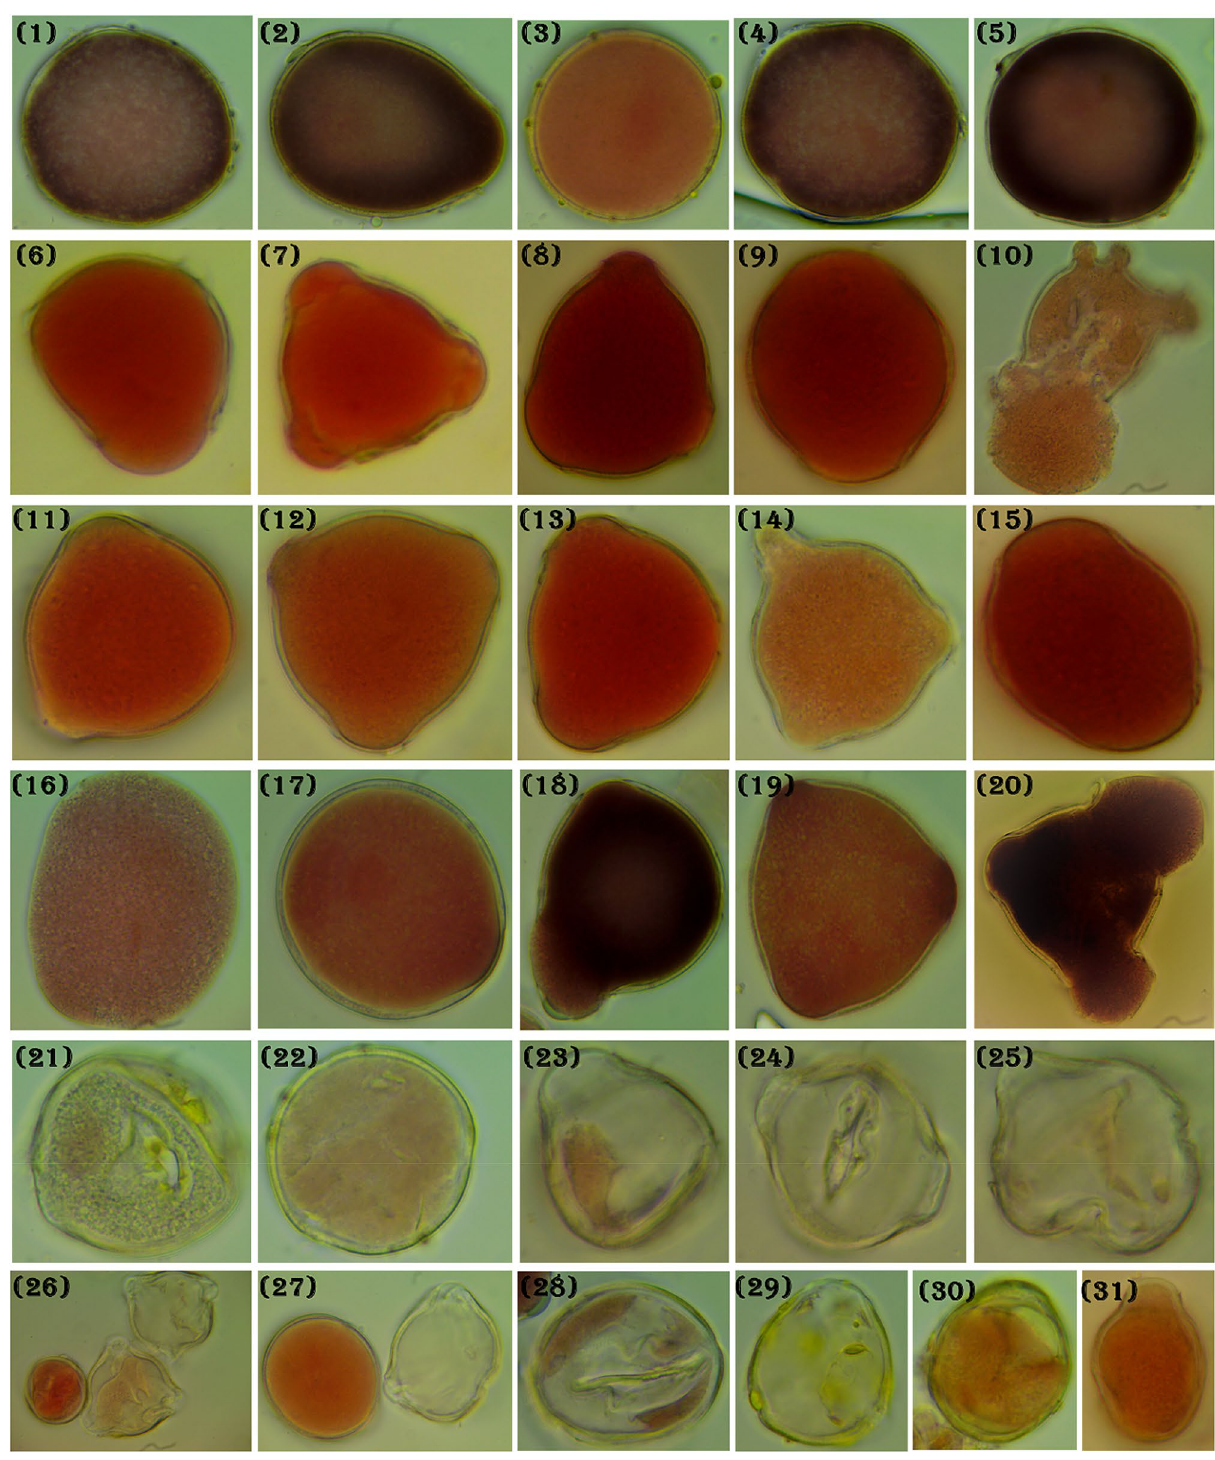
Figure 5. Showing the pollen grains viability and aberration of Zn NP as follow: ( 1 – 5 ) control, ( 6 – 10 ) 2.5 mL/L, ( 11 – 15 ) 5 mL/L, ( 16 – 12 ) 7.5 mL/L and ( 21 : 31 ) different types of aberrations on Florida prince” peach cultivar during 2020 season (100